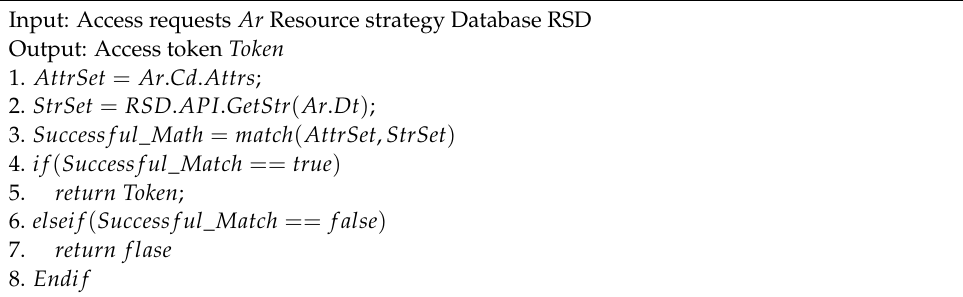
Algorithm 1: Intra-Domain Access Control